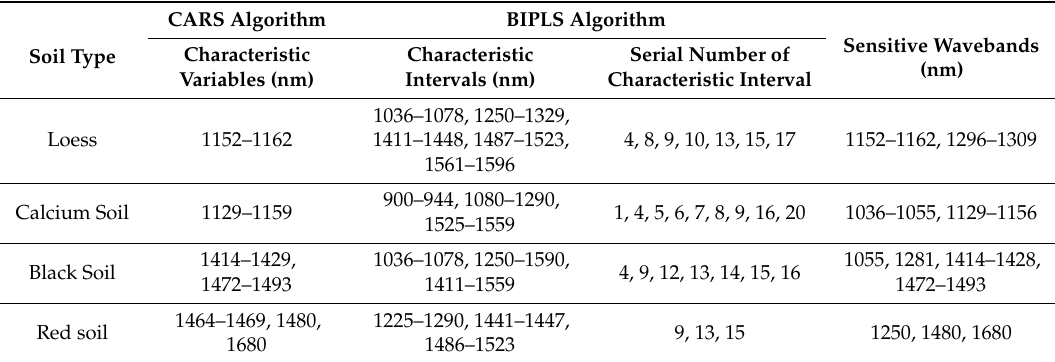
Table 2. The selected characteristic variables, characteristic intervals, and sensitive